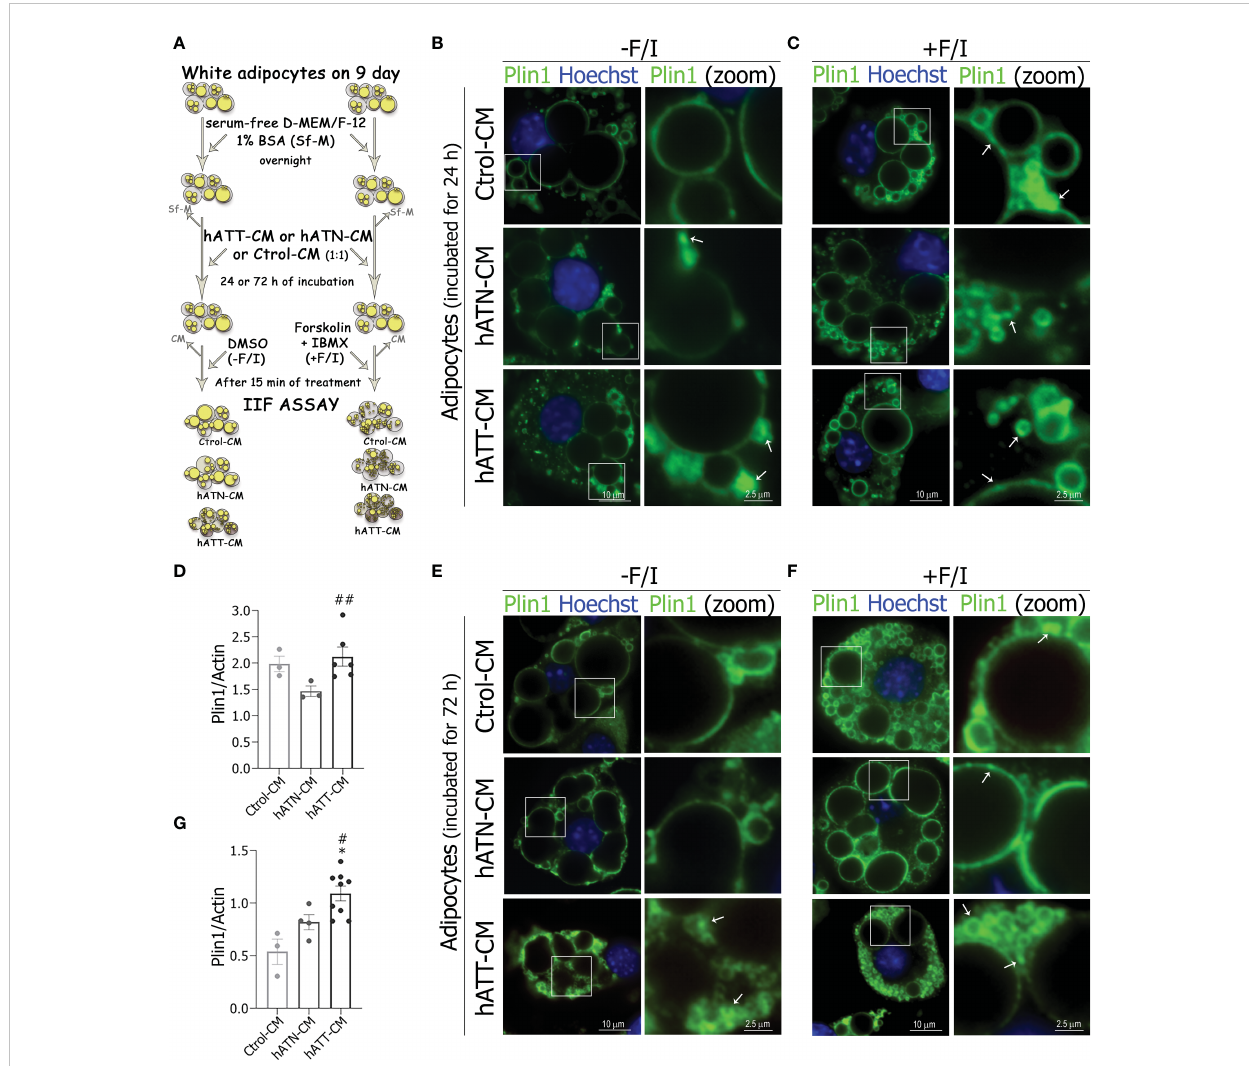
FIGURE 7 Effect of CM from hATN and hATT on the localization/protein expression of Plin1 in mature adipocytes. 3T3-L1 adipocytes were incubated with hATN-, hATT- or Ctrol-CM followed by incubation with DMSO (-F/I, basal condition) or 20 µM forskolin plus 0.5 mM IBMX (+F/I, lipolytic condition) for 15 min. (A) Schematic experimental approach. 3T3-L1 adipocytes after 24 (B, C) and 72 h (E, F) of treatment, under basal condition (B, E) or lipolytic condition (C, F) , were subjected to IIF with the indicated antibodies, and images were analyzed by confocal microscopy (magni fi cation x600; see Materials and methods section for further details). Boxed areas are shown as zoomed images on right: Plin1 (zoom). White arrows indicate Plin1 segregation. Notably, the rimming observed on the pattern of Plin1 immuno fl uorescence on large LDs evidenced less fl uorescence intensity in adipocytes treated with hATT-CM and hATN-CM for 24 and 72 h, under basal conditions. 3T3-L1 adipocytes were incubated with hATN-, hATT- or Ctrol-CM for 24 and 72 h, then lysed and Plin1 expression was measured by WB (D, G) . Actin was used as a loading control. (n = 3 experiments in duplicate). Images were analyzed by densitometry. Student ’ s t-test with Welch´s correction was performed; *P<0.05, adipocytes incubated with hATT-CM vs. Ctrol-CM; #P<0.05, and ##P<0.01, adipocytes incubated with hATT-CM vs. hATN-CM. Ctrol-CM, control conditioned media; hATN- CM, conditioned media from human normal breast adipose tissue explants; hATT-CM, conditioned media from human breast cancer adipose tissue explants; Plin1, perilipin